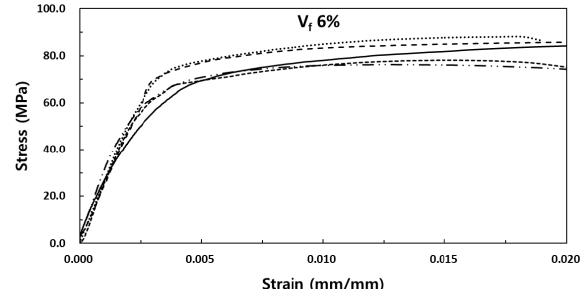
Figure 8. Stress-strain curve for the fiber volume fraction of 6%.